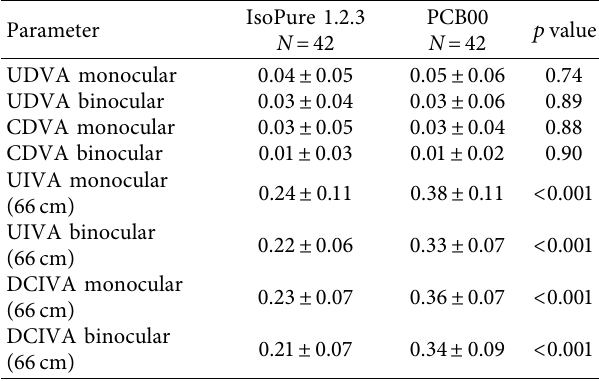
Table 3: Twelve month postoperative visual